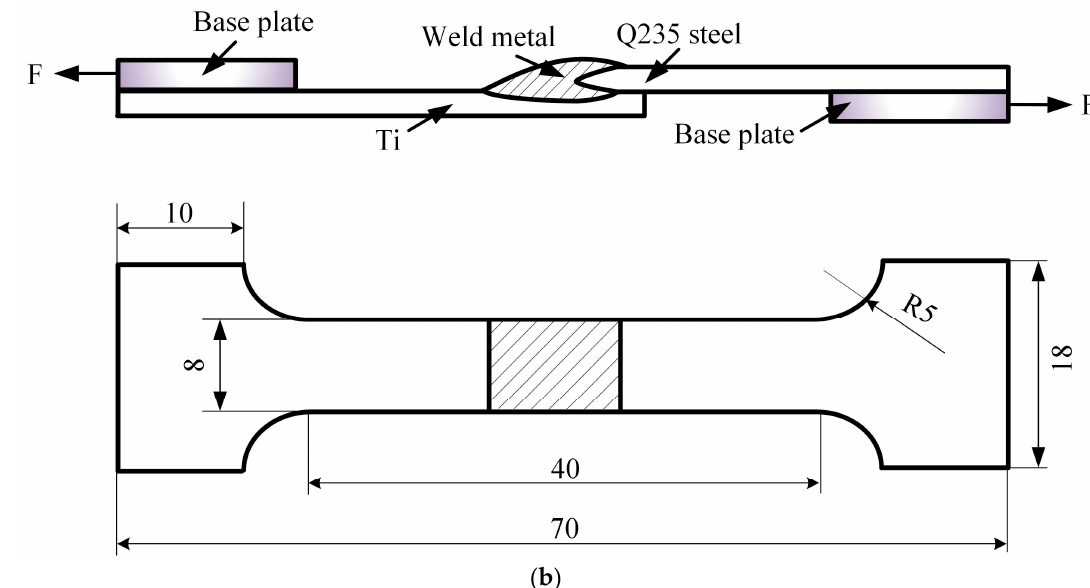
Figure 3. Dimensions (in mm) and configuration of the tensile samples: ( a ) Joint I (sample #1) and ( b ) Joint II (sample #2).